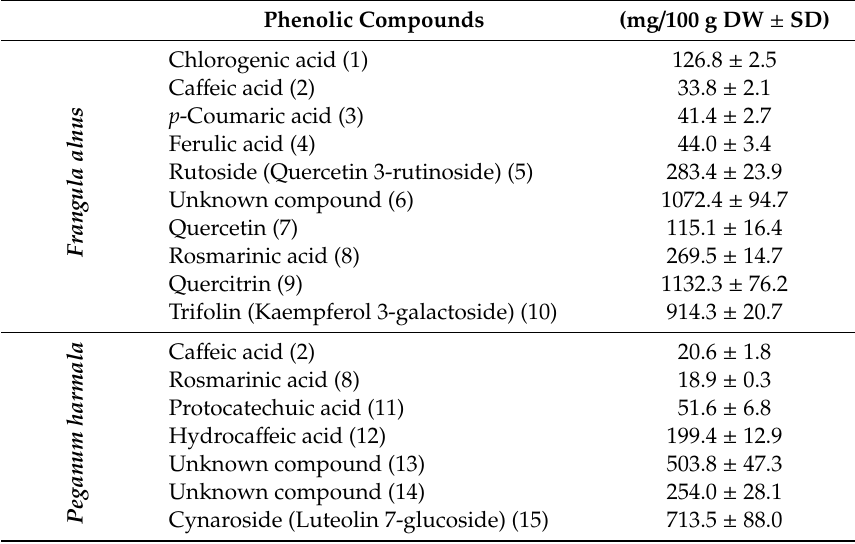
Table 1. The polyphenolic composition of F. alnus and P. harmala leaf extracts (mg / 100 g DW ±